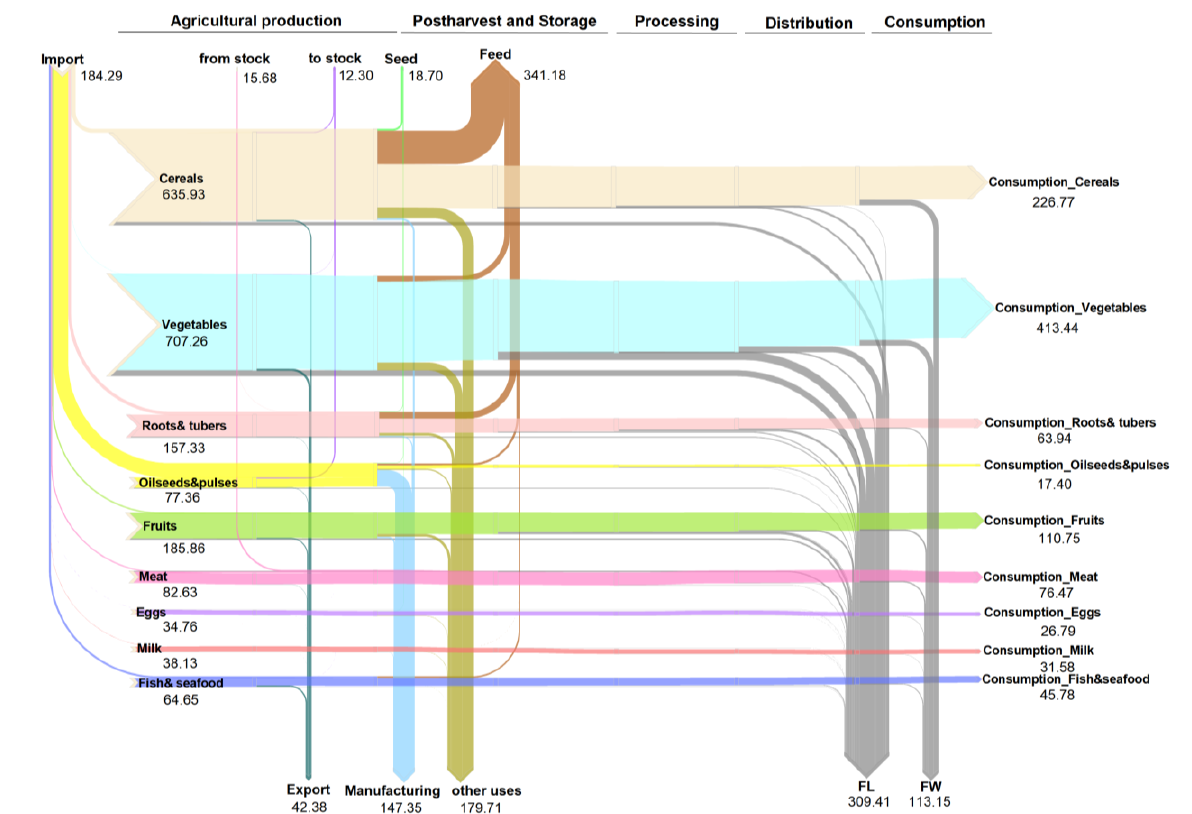
Figure 3. Sankey diagram of the food flows and FLW generated along the FSC. (FL and FW were quantified for each stage of the FSC for nine major agrifood categories (labels on left). Values are in Mt; data are for the year 2019.).